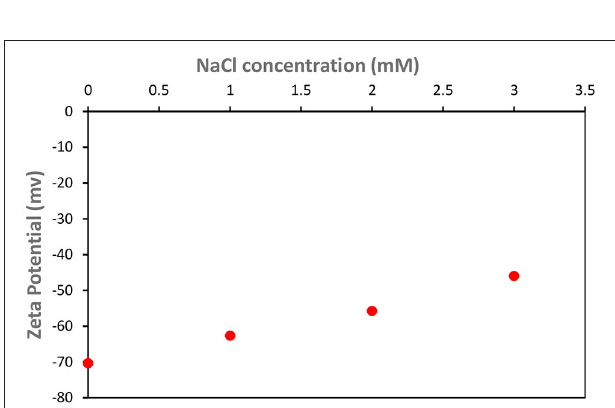
FIGURE 7 | Effect of NaCl addition on the zeta potential of CNC Suspension at pH = 7 and room temperature.